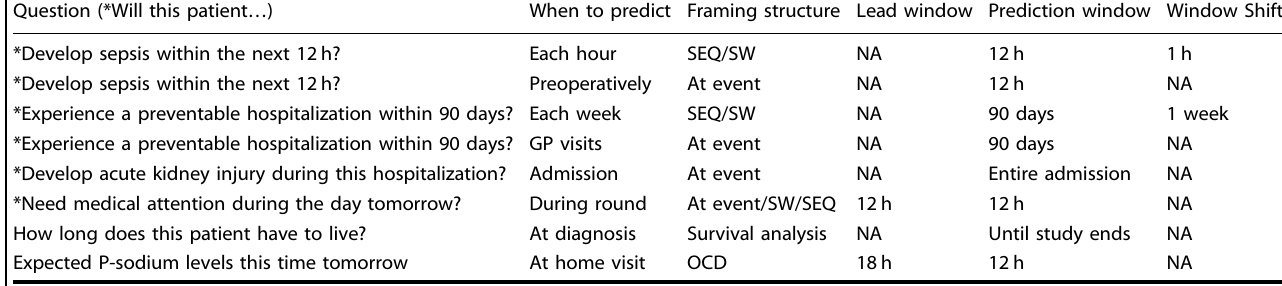
Table 4. Examples of clinical questions and a corresponding framing. Question (*Will this patient … ) When to predict Framing structure Lead window Prediction window Window